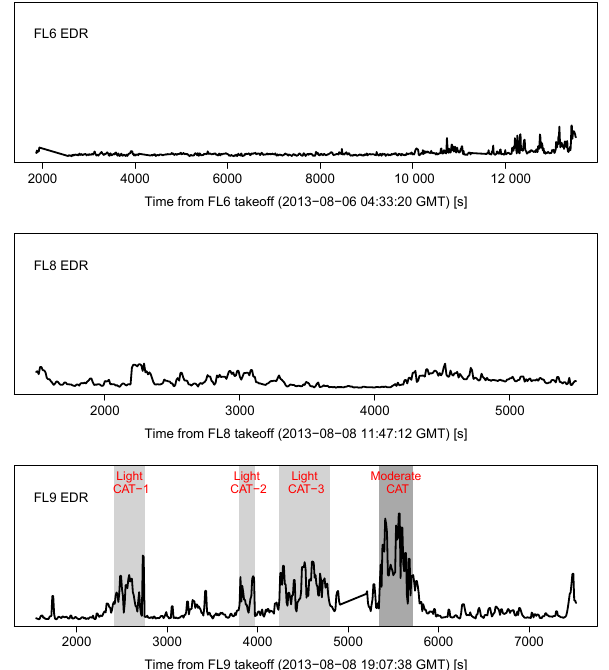
Figure 2. Reference EDR recordings from the DELICAT flights FL6, FL8, and FL9. Plots show 15s maxima of the EDR in the cruise fragments of the flights. Vertical scale is arbitrary (yet the same on all plots) as EDR is scalable by a constant. Shaded areas in FL9 pane are the CAT occurrences (as in Fig. 1).